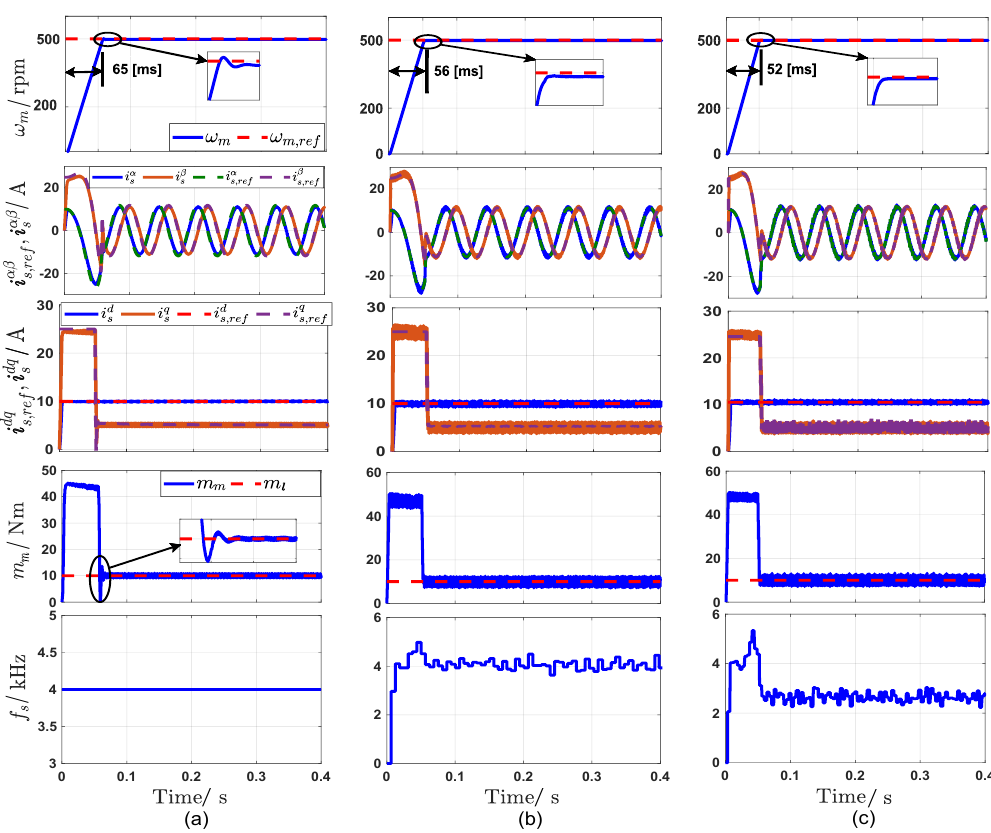
Figure 9. Overall performance of the different control strategies under rotor mechanical speed 500 [rpm]: ( a ) FOC, ( b ) CPC, and ( c ) proposed SPC.